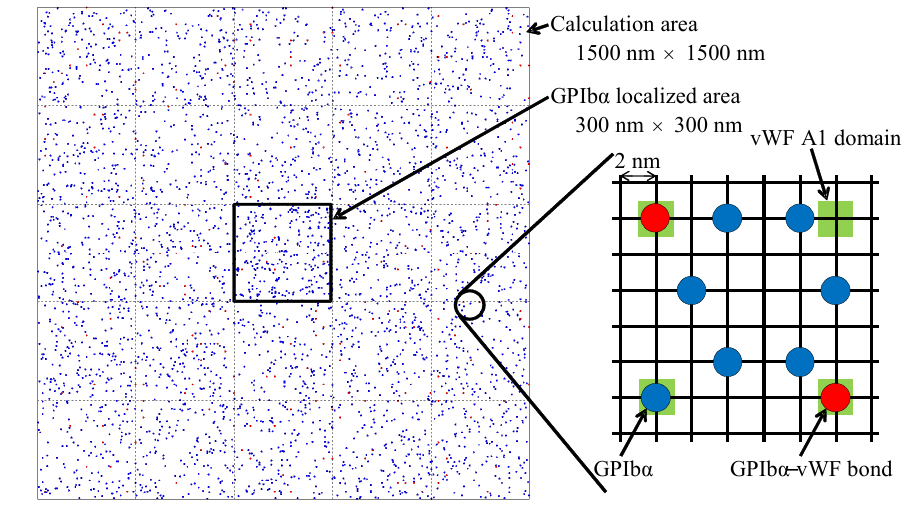
Fig. 2 kMC lattice model of a platelet